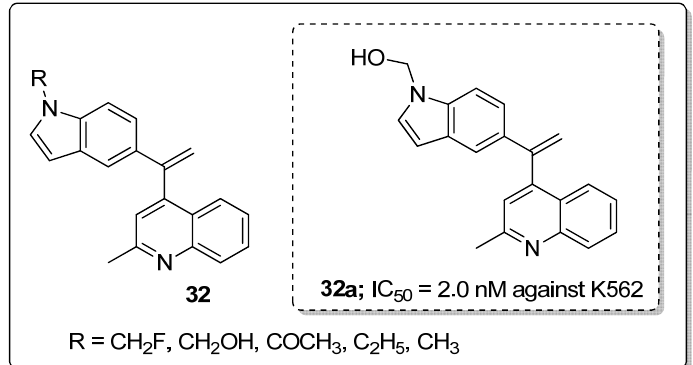
Figure 37. Antiproliferative activity of the most active indole ‐ quinoline hybrid 32a .